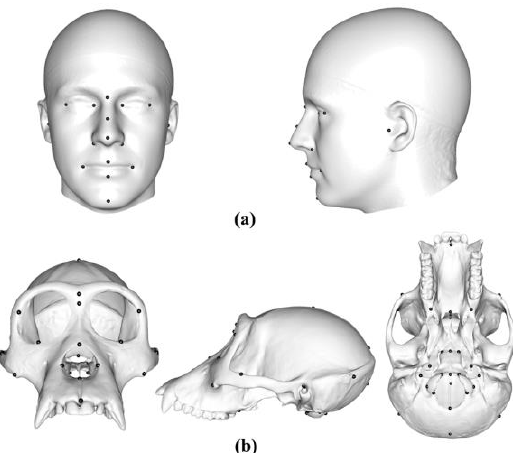
Figure 1. Two datasets. ( a ) The human template head with 16 landmarks. ( b ) The ape template cranium with 41 landmarks.